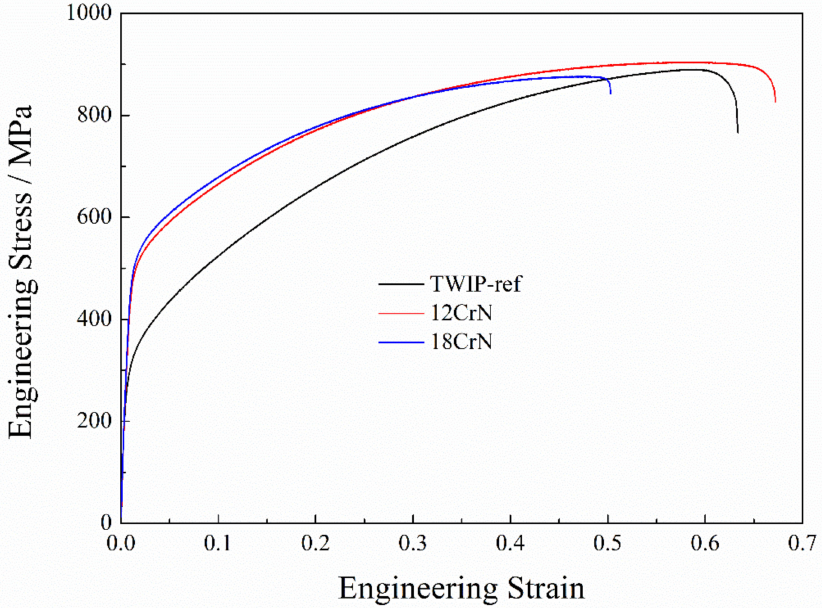
Figure 4. The engineering stress–strain curves of Fe–Mn–Cr–CN steel compared to TWIP-ref steel. Figure 5 shows the TEM images of the 12CrN and 18CrN samples in the solution state, and they all have relatively low-density dislocations with significant twins. Figure 6 shows the precipitation, the inset diffraction pattern, and the EDS analysis of the 18Cr TWIP steel in a solution state. From the results of the EDS analysis and the diffraction pattern, the precipitation was identified as M 23 C 6 enriched with Mn and Fe.